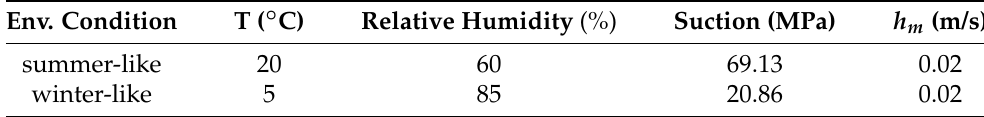
Table 4. Synthesis of parameters in two different environemental